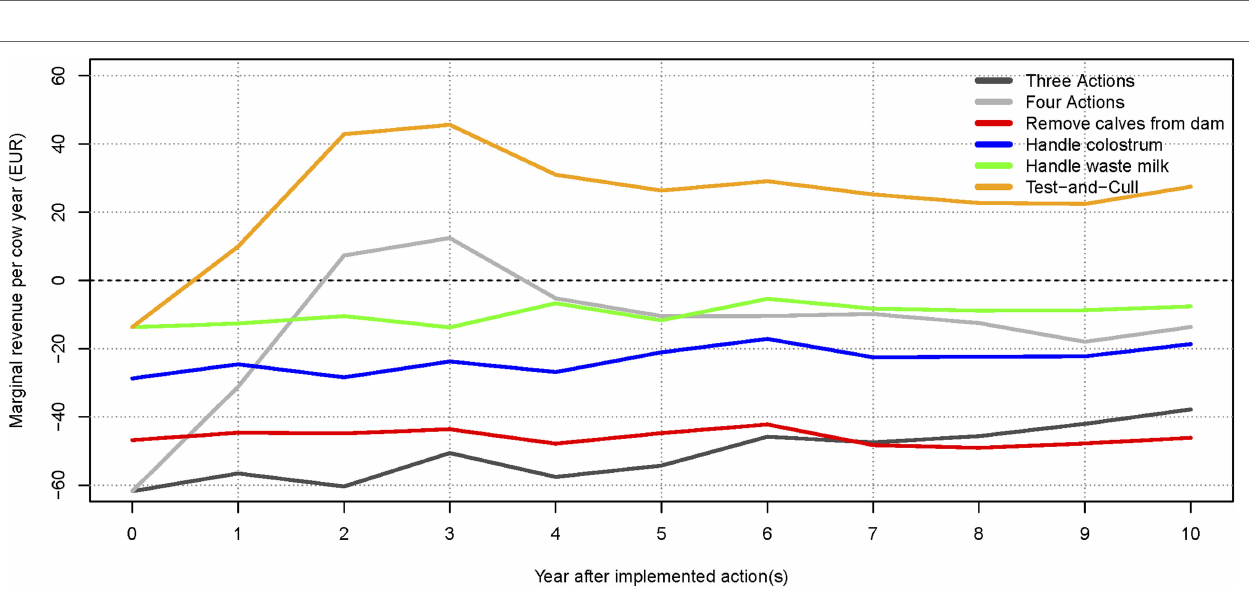
FIGURE 4 | True prevalence: 50% simulation envelope over 10 simulated years for the tested scenarios in the low-hygiene herd . (A) “Three control actions” means the three control actions in (B) . “Four control actions” means the three actions in (B) plus test-and-cull. (B) “Handle waste milk” and “handle colostrum” means that the farmer only uses milk or colostrum from test-negative cows for feeding calves.